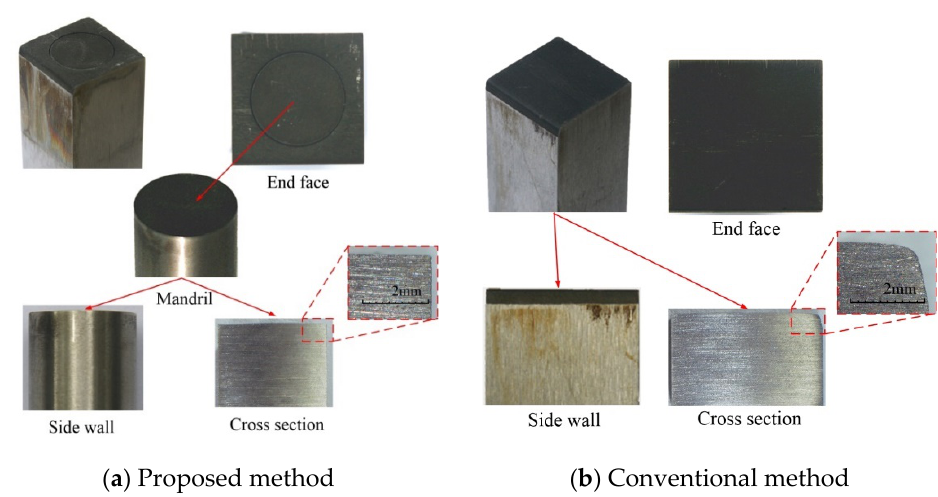
Figure 16. Specimens with a feed rate of 0.1 mm/min.